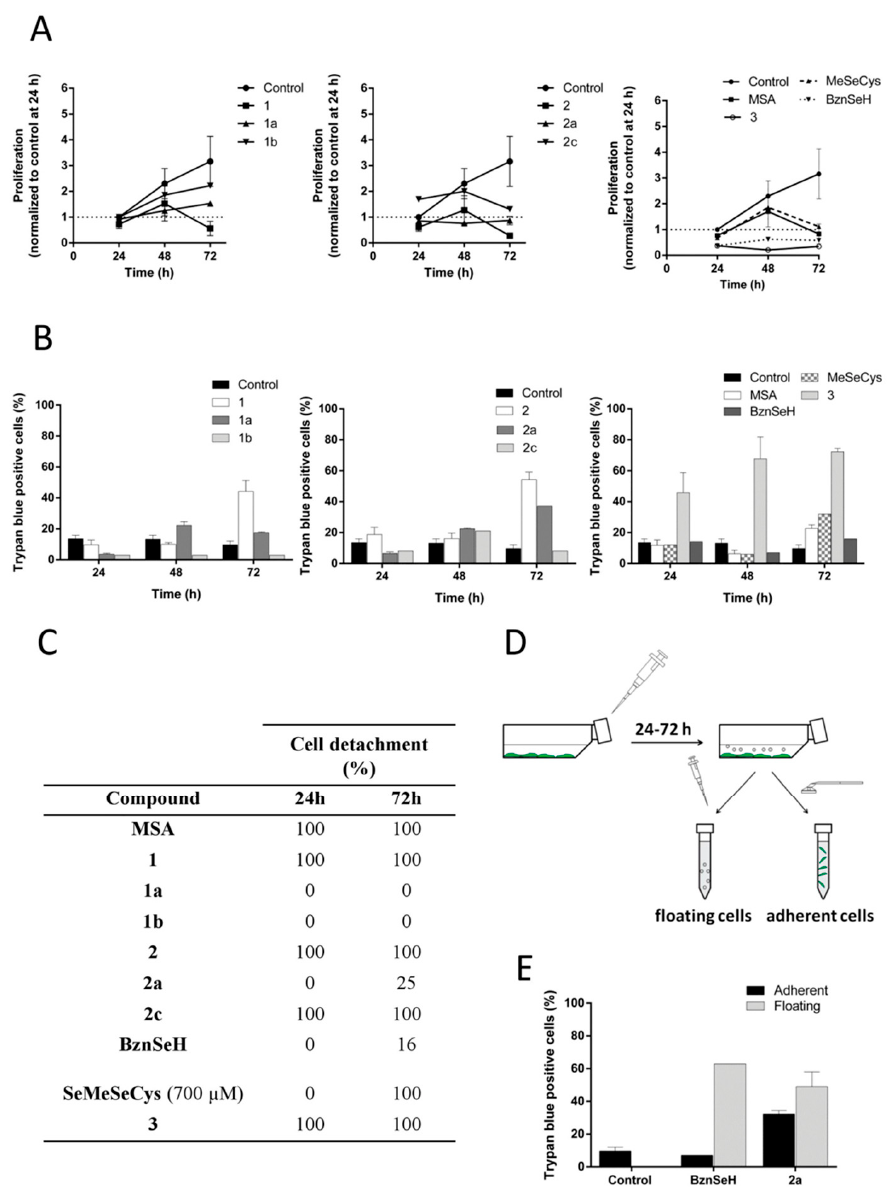
Figure 5. Evaluation of the antiproliferative, cytotoxic, and de-adhesive properties of other Se analogs. Cells were seeded and incubated for 24 h before starting treatments with the compounds. Cell proliferation ( A ) and cell death based on Trypan blue exclusion ( B ) were analyzed after treatment with a 5 µ M dose. For MeSeCys, a 700 µ M dose was used. For BznSeH and compound 2a , inducing a floating and attached population, proliferation, and cell death were calculated without taking into account the two populations in this case. ( C ) Cell detachment quantification after treatment. ( D ) Procedure scheme to evaluate the attached and floating population. Floating cells were collected with a pipette and remaining cells were considered as attached and slightly scrapped. ( E ) Cell death comparison in the floating and adherent populations induced by compound 2a and